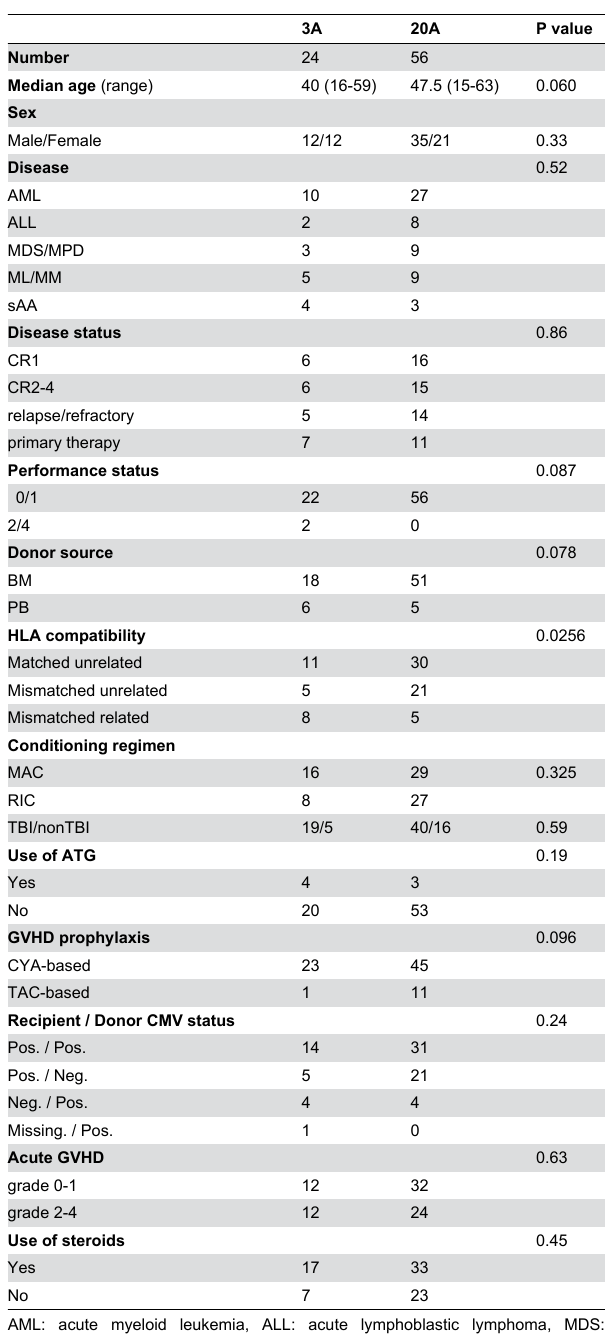
Table 1. Patient